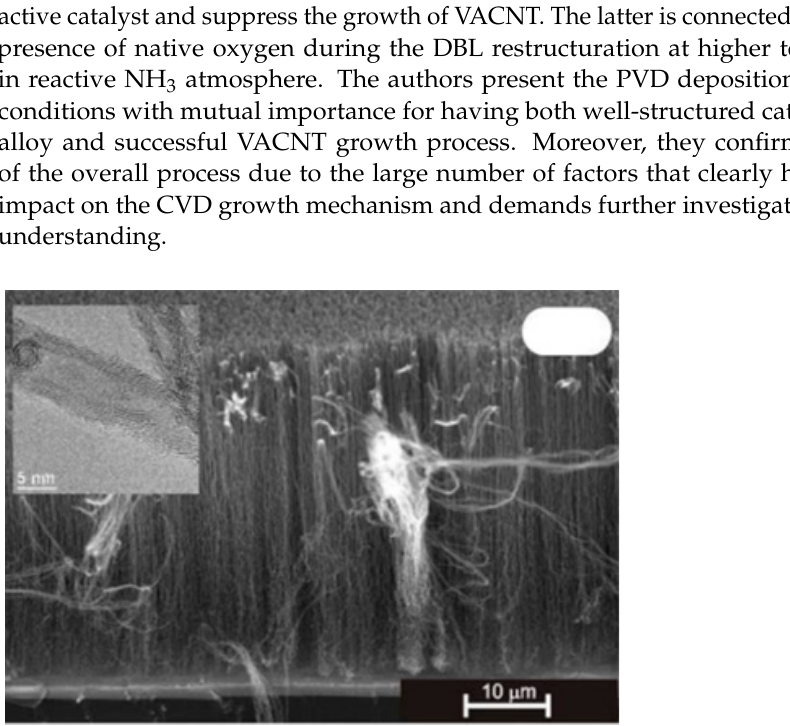
Figure 7. SEM micrograph of VACNT on 25 nm thick Co-Zr-N-(O) alloy DBL after CVD synthesis at 600 °C for 10 min; Reprinted with permission from Mierczynskia, Journal of Materials Science & Technology; Ref. [112] copyright 2018, Elsevier.